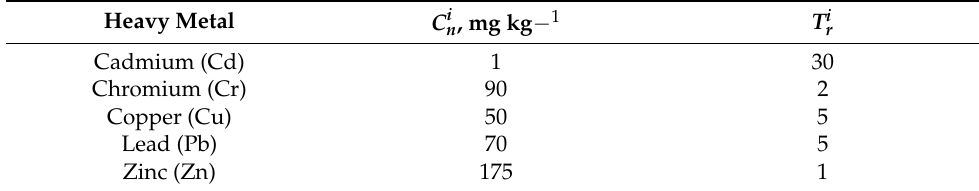
Table 2. Background reference values C i n and T i r